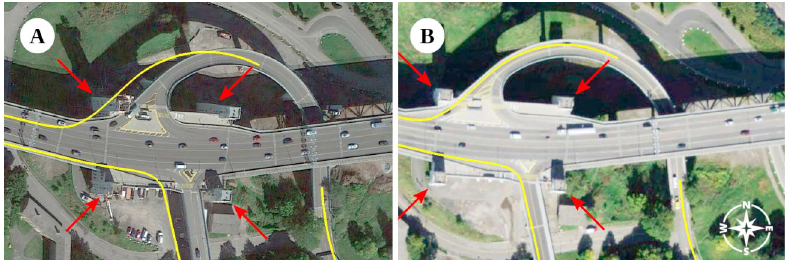
Fig. 5. (A) Relief displacement over the central part of the jacques Cartier Bridge, the city of Montreal. (B) The displacement is reduced when the relief is near the nadir point. The yellow line shows the trajectory measured with the GPS receiver, and red arrows point to the four towers around the structure. This location is marked by a red diamond in Fig. 1